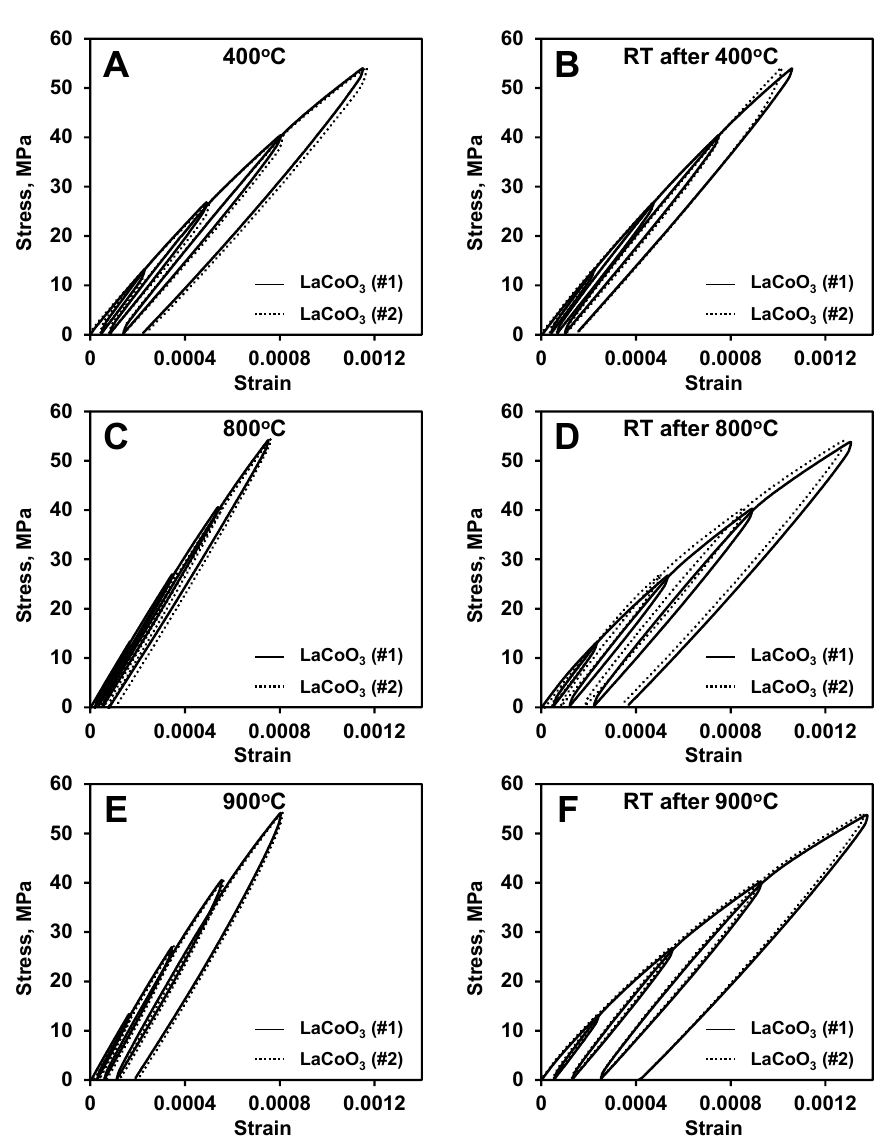
Figure 3. A comparison of different heating history stress–strain deformation plots of LaCoO 3 sample #1 and sample #2 at: ( A ) 400 °C ; ( B ) RT after 400 °C ; ( C ) 800 °C ; ( D ) RT after 800 °C ; ( E ) 900 °C ; ( F ) RT after 900 °C.